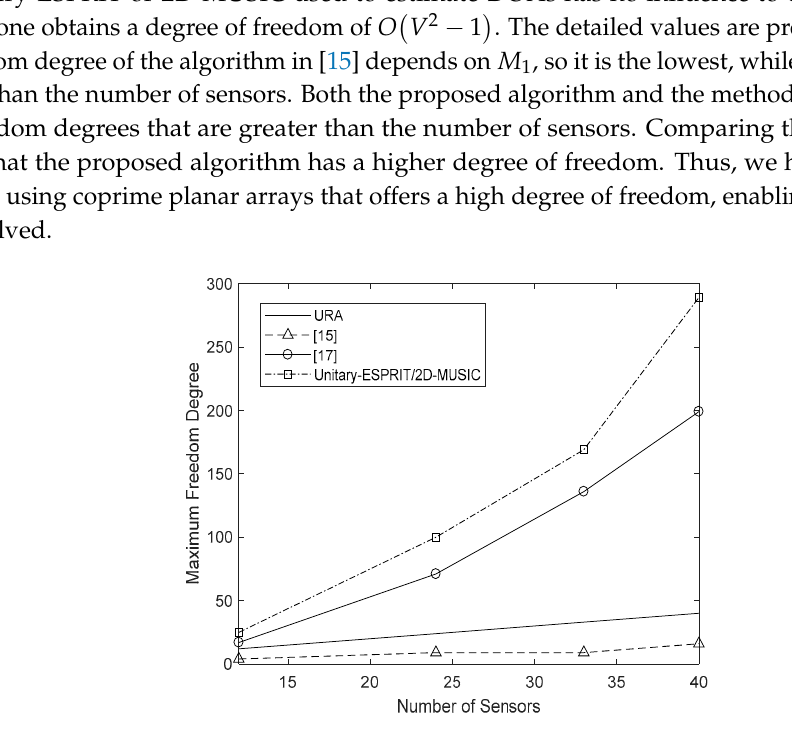
Figure 4. Freedom degree versus the number of sensors.